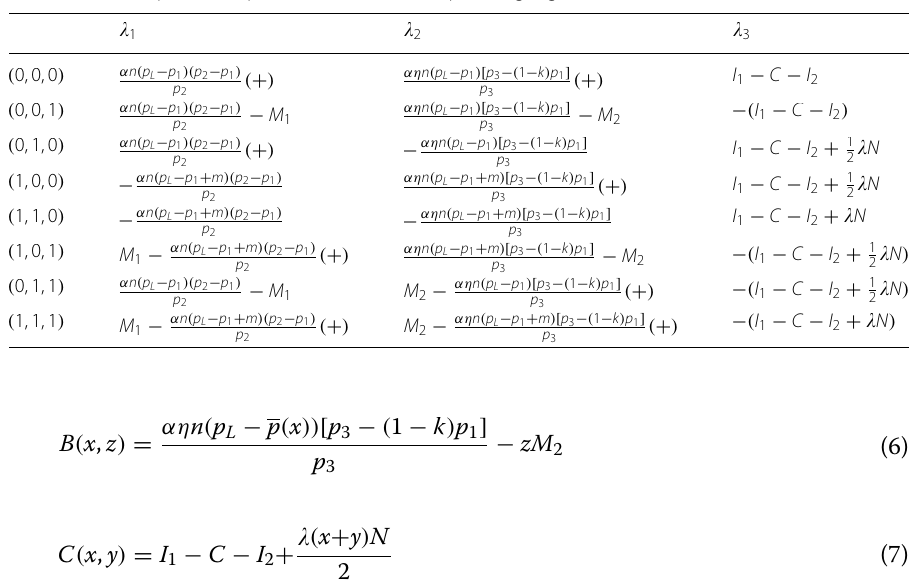
Table 3 local equilibrium points and their corresponding